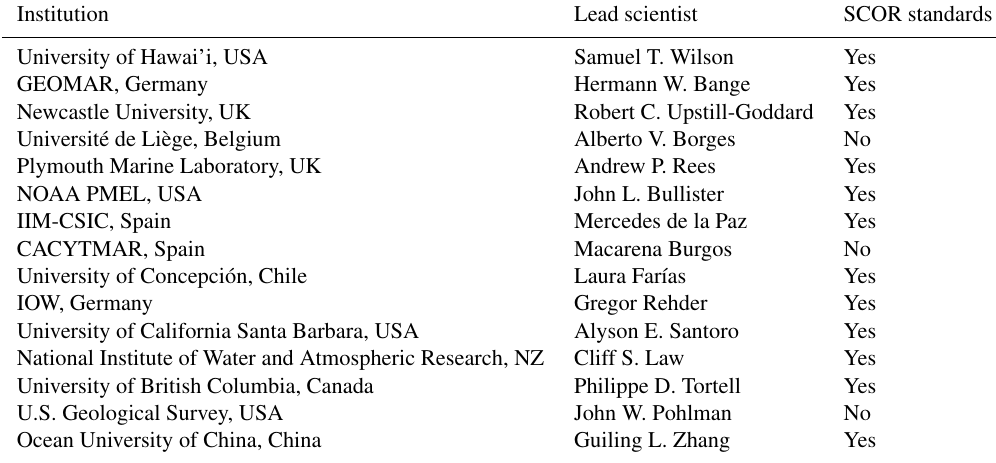
Table 1. List of laboratories that participated in the intercomparison. All laboratories measured both methane and nitrous oxide except the U.S. Geological Survey (methane only), UC Santa Barbara (nitrous oxide only), and NOAA PMEL (nitrous oxide from the Pacific Ocean). Also indicated are the 12 laboratories that received the SCOR gas standards of methane and nitrous